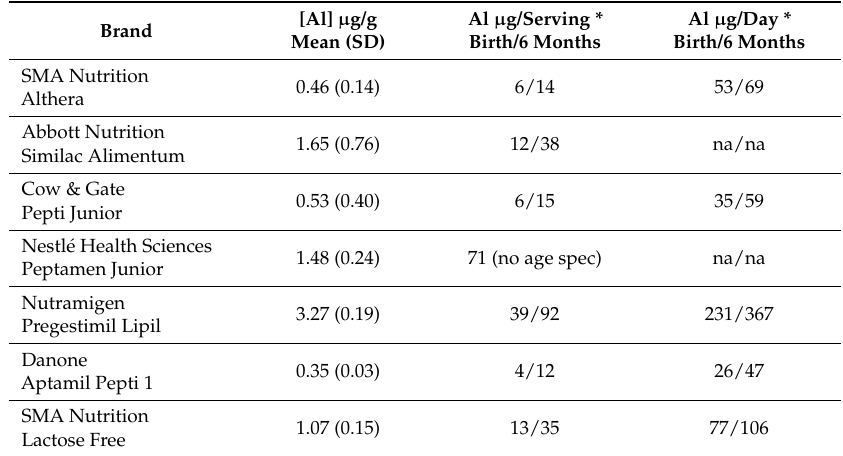
Table 3. Aluminium in powdered formulas designed for infants with allergies and intolerances. Mean and SD are given, n =